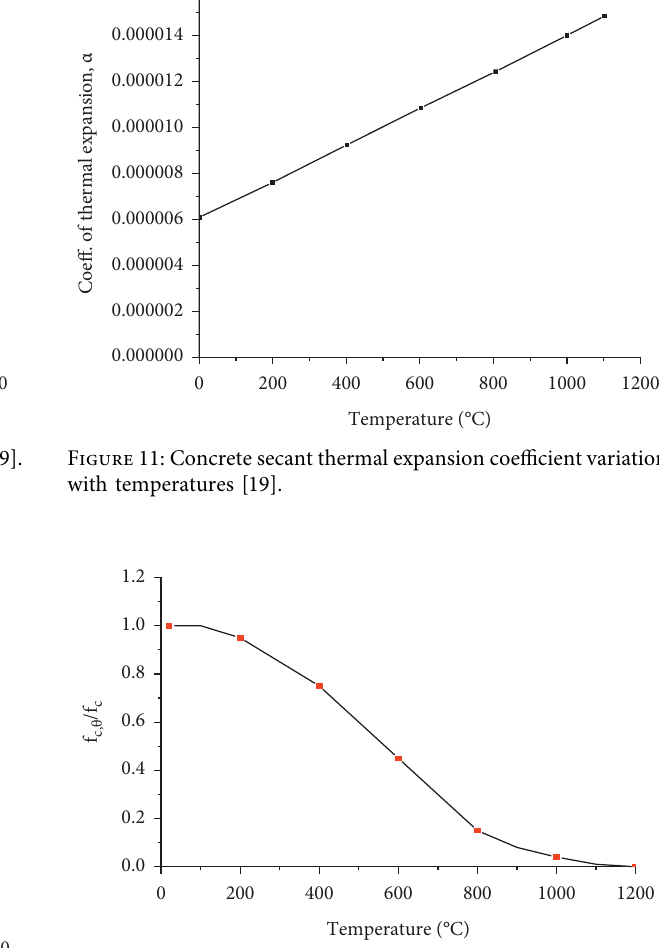
Figure 12: Concrete compressive strength reduction factor at elevated temperatures